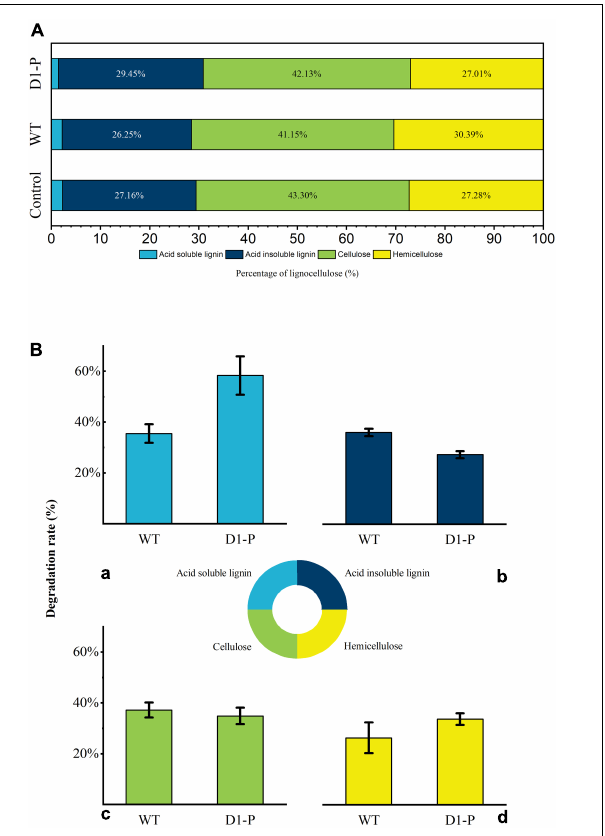
FIGURE 2 | (A) Percentage of lignocellulose components in samples. (B) The degradation rate of lignocellulose by WT and D1-P determined by HPLC: (a) acid-soluble lignin; (b) acid-insoluble lignin; (c) cellulose; (d) hemicellulose.